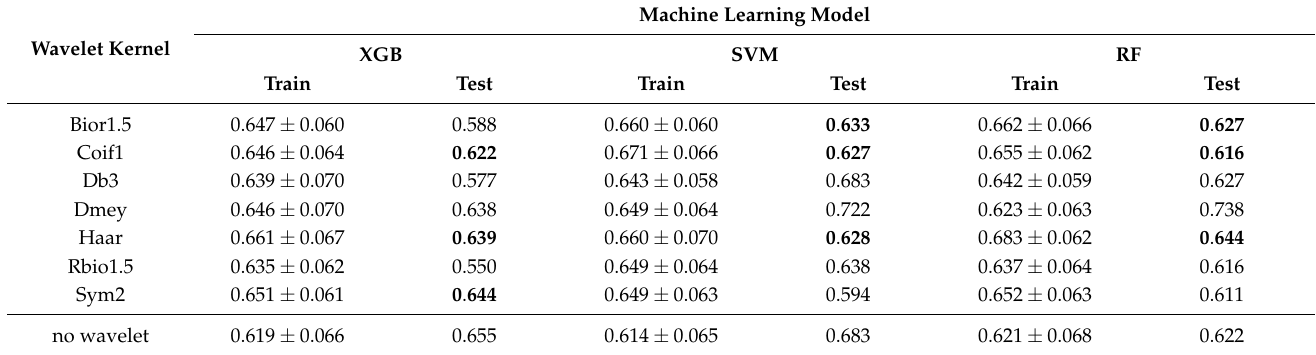
Table 5. Sensitivity values obtained in training ( mean ± standard deviation ) and in testing phases for each wavelet kernel, with three ML models considered. Boldface values highlight the best three obtained results.